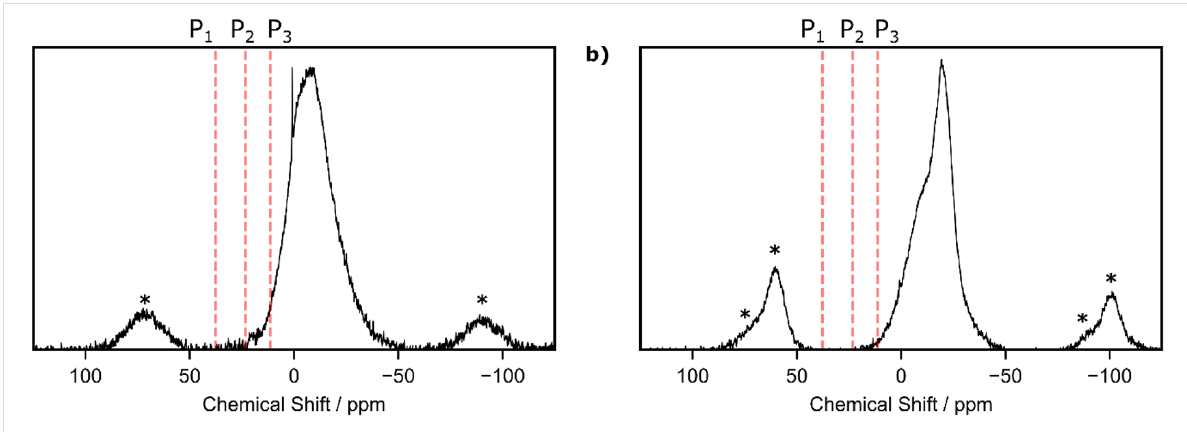
Figure 3: 31 P MAS NMR of a) g-h-PCN and b) g-h-PCN300. Asterisks denote spinning